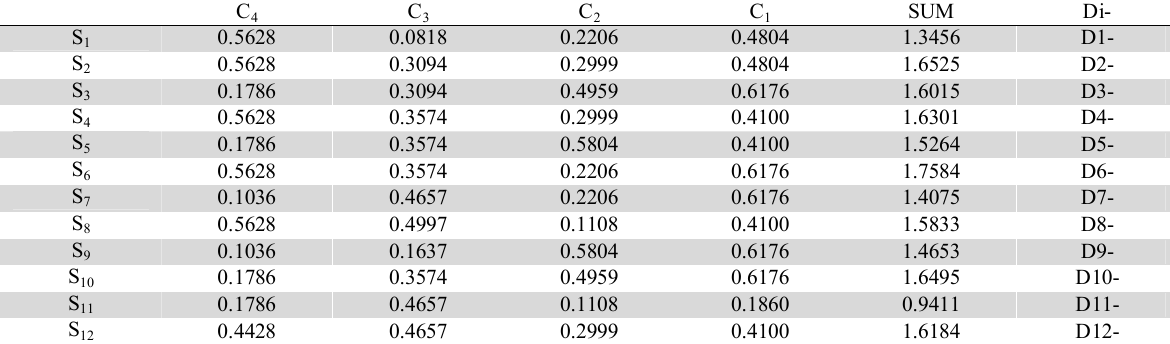
The summary of the results of the survey for the ideal negative factors